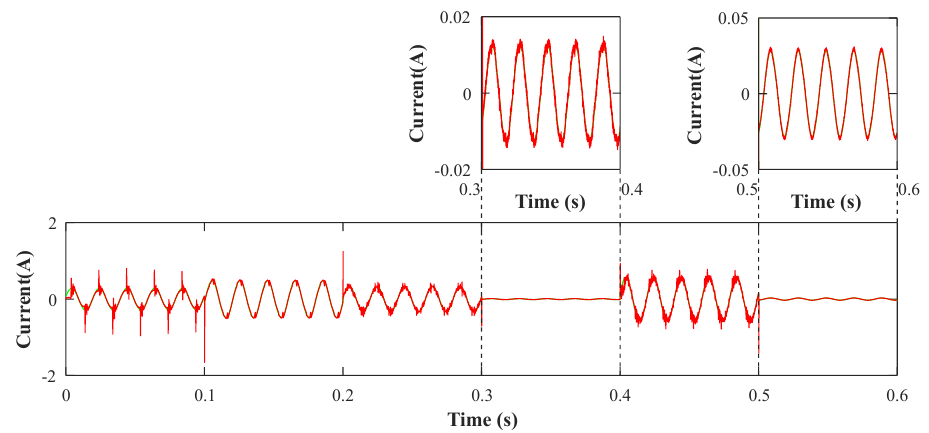
Figure 13. Input signal after filtation using the RLS algorithm; filter length 2, forgeting factor 0.999, delay 100 µ